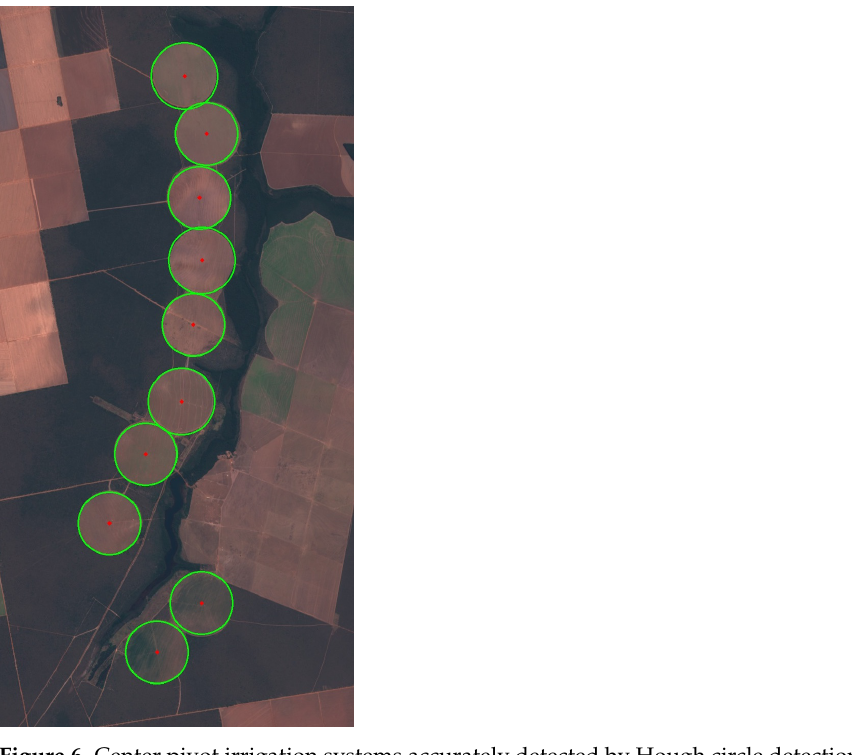
Figure 6. Center pivot irrigation systems accurately detected by Hough circle